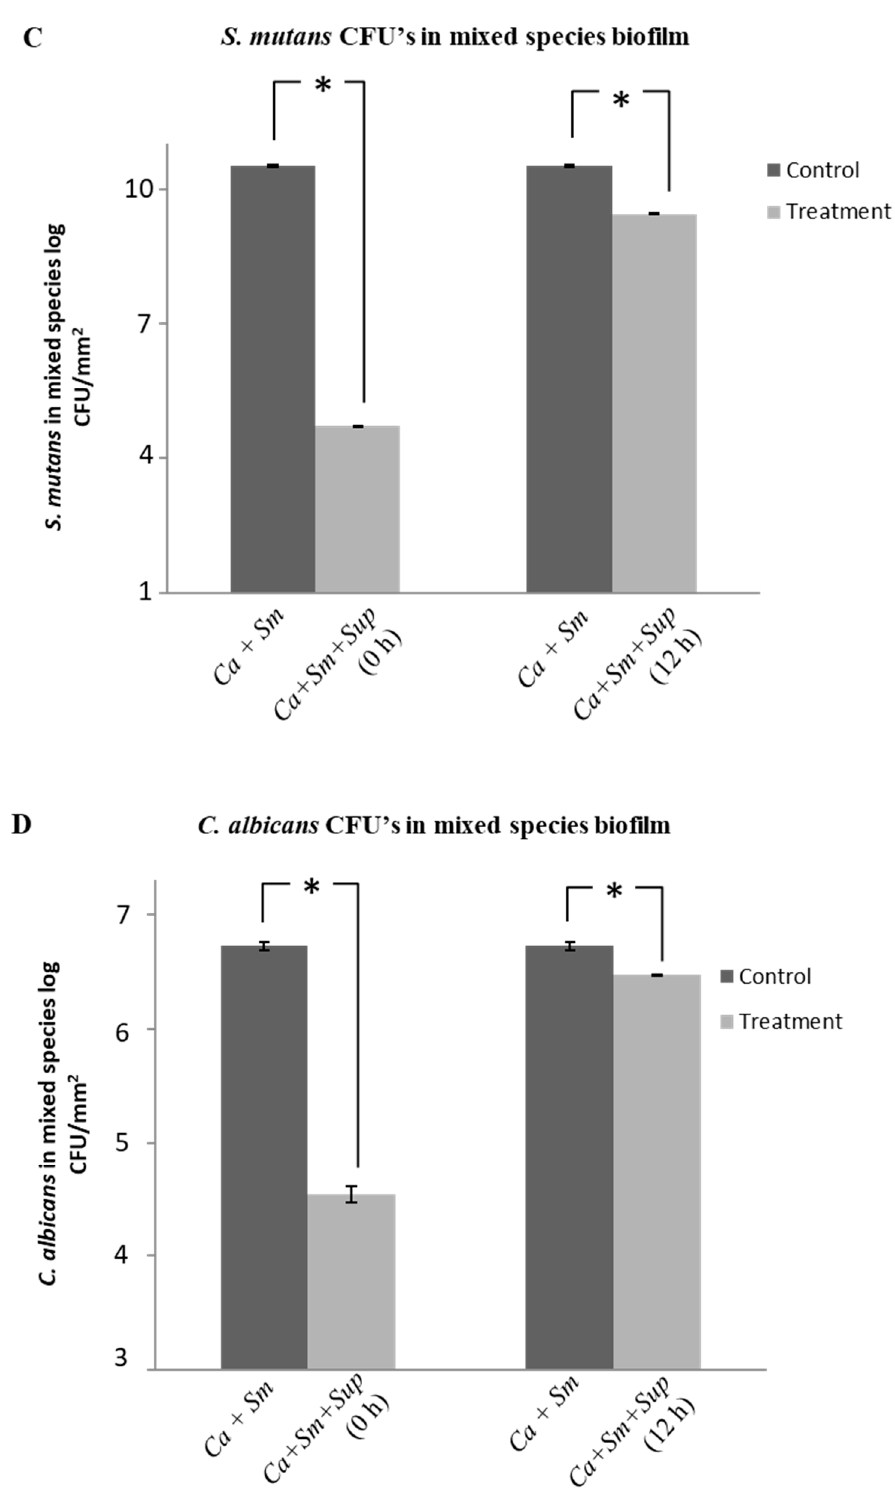
Figure 4. Lactobacillus plantarum 108 supernatant (Sup) inhibited S. mutans (Sm) and C. albicans (Ca) mixed species biofilms. The supernatant was introduced into the mixed-species biofilm at 0 h (preventive assay) and at 12 h (therapeutic assay). Biofilms were quantified using ( A ) XTT reduction assay, ( B ) Crystal Violet assay and Colony forming unit counting (CFU) for ( C ) S. mutans , and ( D ) C. albicans. Data are presented as mean ± SD and statistical significance (*) was evaluated with respect to the untreated group (p < 0.05).